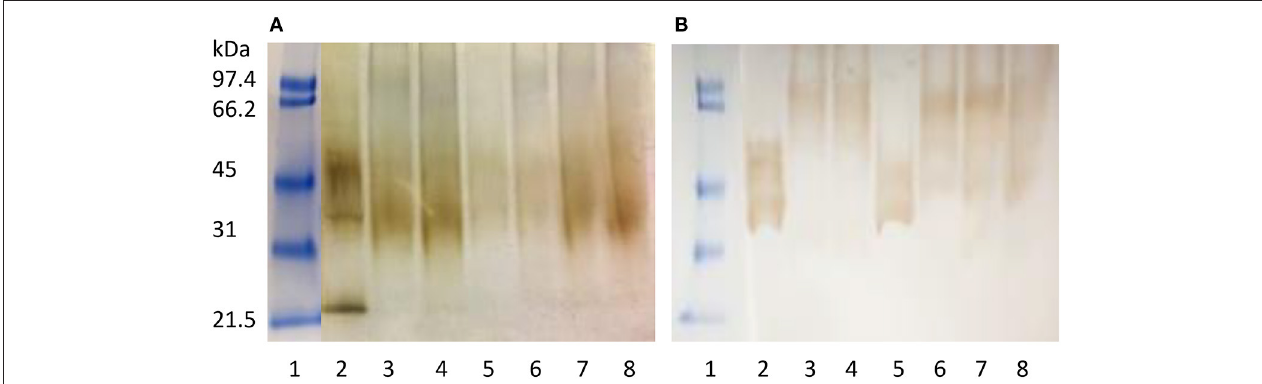
FIGURE 2 | Immuno-reactive proteins in gluten-free (GF)-labeled foods detected with IgA of a pool of sera from three patients with celiac disease (CD). (A) : Coomassie blue and silver stained electrophoresis gel and (B) : blots after incubation with the sera pool. Lane 1: m.w.std., lanes 2–8: extracts of gluten contaminated foods with 40–12,279 mg/kg